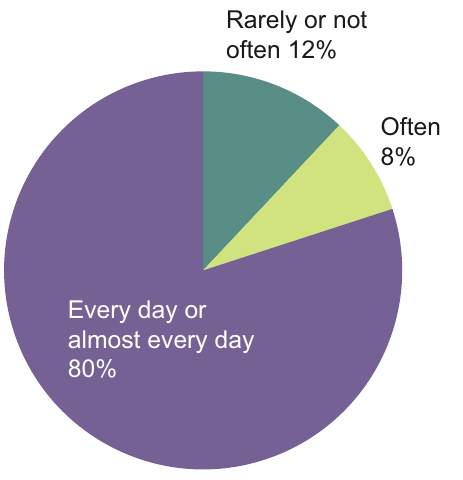
Figure 3. Frequency of Excel use reported by researchers surveyed. n =